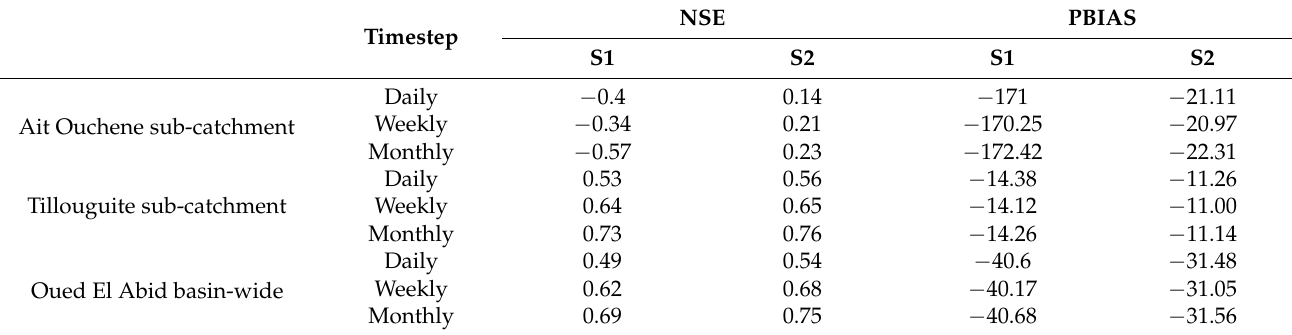
Table 4. Statistical criteria between simulated SWAT-SCA and